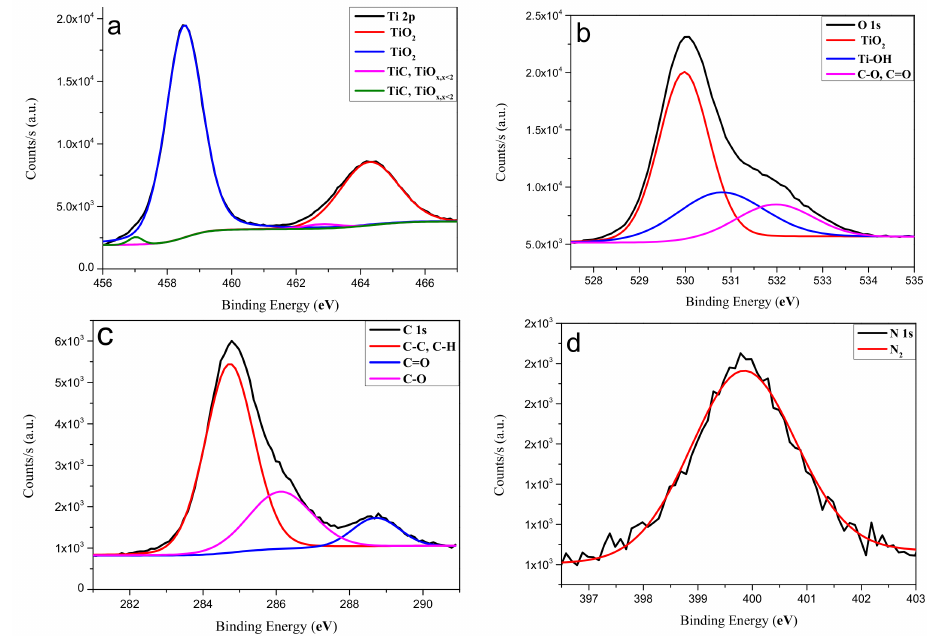
Figure 7. High-resolution XPS spectra of ( a ) Ti 2 p , ( b ) O 1 s , ( c ) C 1 s and ( d ) N 1 s of coated wood using Gaussian–Lorentzians